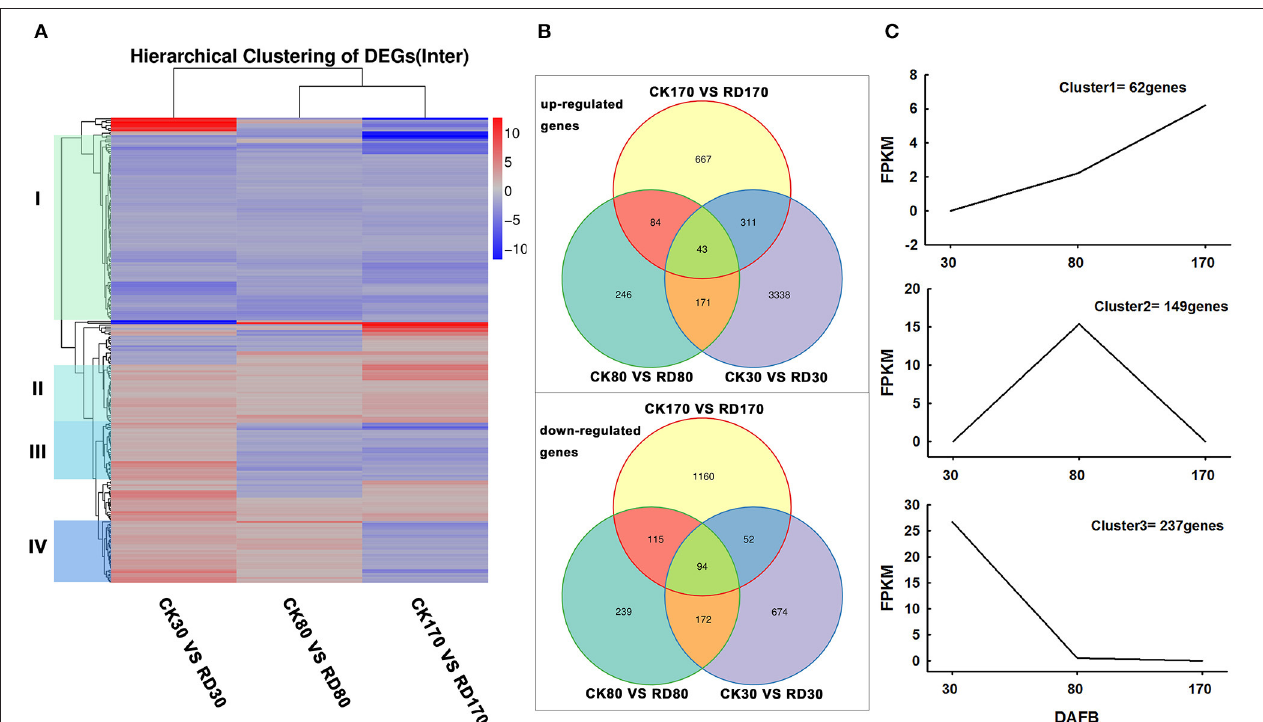
FIGURE 5 | Overview of top 20 altered pathways in RD peel at three development stages.